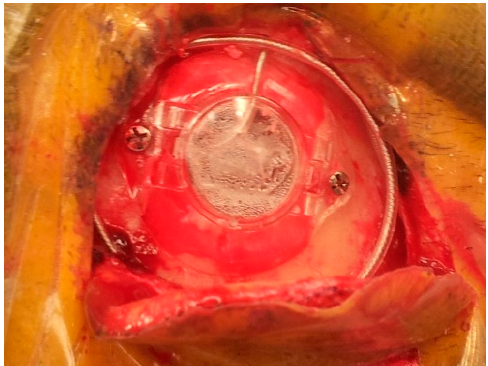
Figure 13. The final appearance of the electrode fixed using the Stimloc device; the excess of the electrode is coiled around the burr hole to create a strain relief loop.